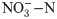
Soil potential mineralizable N (PMN) and NO3--N in bare and cover micro-plots of the studied topographical positions following red clover and rye cover crops.The data shown are the averages from 2011, 2012 and 2013 results. Error bars represent standard errors. The ** and * mark the cases when the differences between cover and bare micro-plots were statistically significant at p<0.05 and p<0.1, respectively.